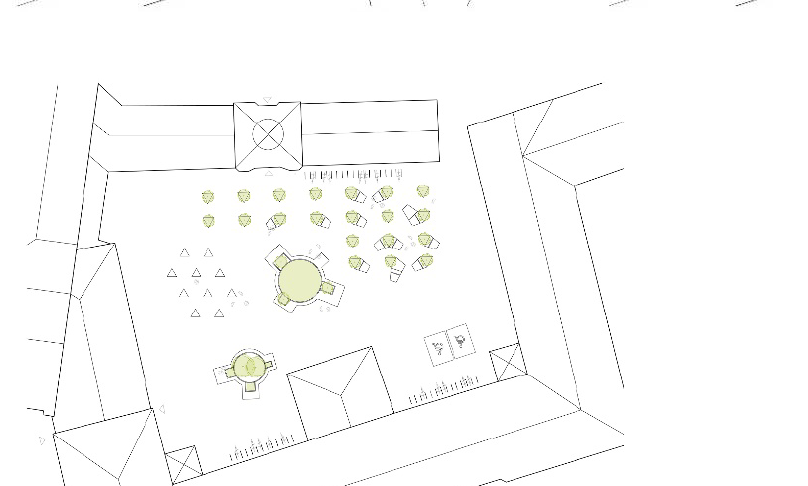
Figure 12. Courtyard City Hall, Poznan after completion in 2019 (Atelier Starzak Strebicki 2019).